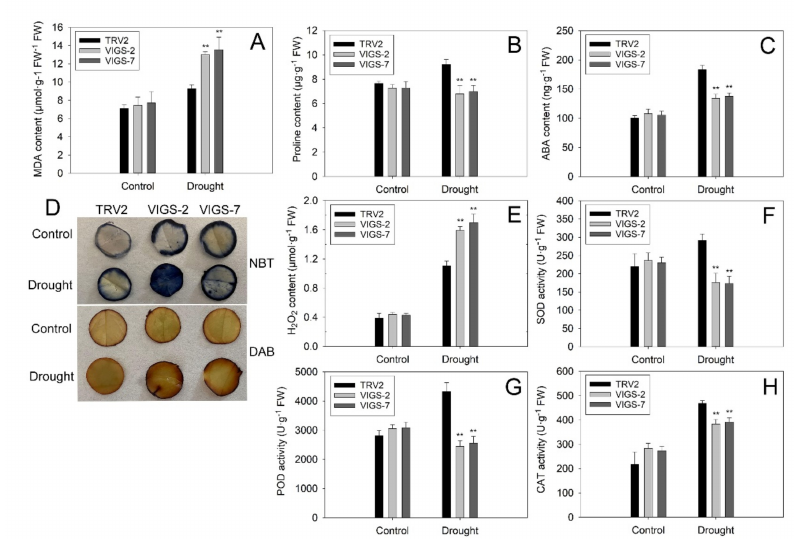
Figure 7. Comparison of physiological changes between the TRV2 and two PtrbHLH66 homolog silencing lemon lines (VIGS-2 and VIGS-7) under normal growth condition (control) and drought (withheld from watering for 3 weeks) stress. The leaves of the two genotypes were collected to measure the ( A ) MDA, ( B ) proline and ( C ) ABA contents, ( D ) NBT and DAB staining, ( E ) H 2 O 2 contents, ( F ) SOD, ( G ) POD and ( H ) CAT activities. All data are shown as the means ± SD calculated from three biological replicates. Asterisks indicate that the values in the two VIGS lemon lines are significantly different from that of the TRV2 plants (** p < 0.01).